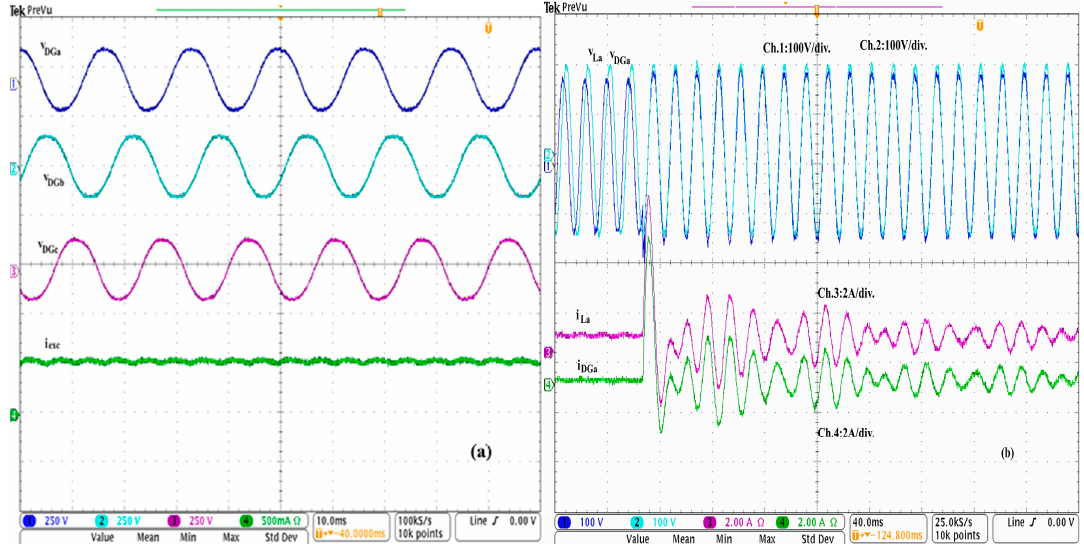
Figure 18. Experimental results of DG: ( a ) steady-state, and ( b ) during synchronization with PCC.